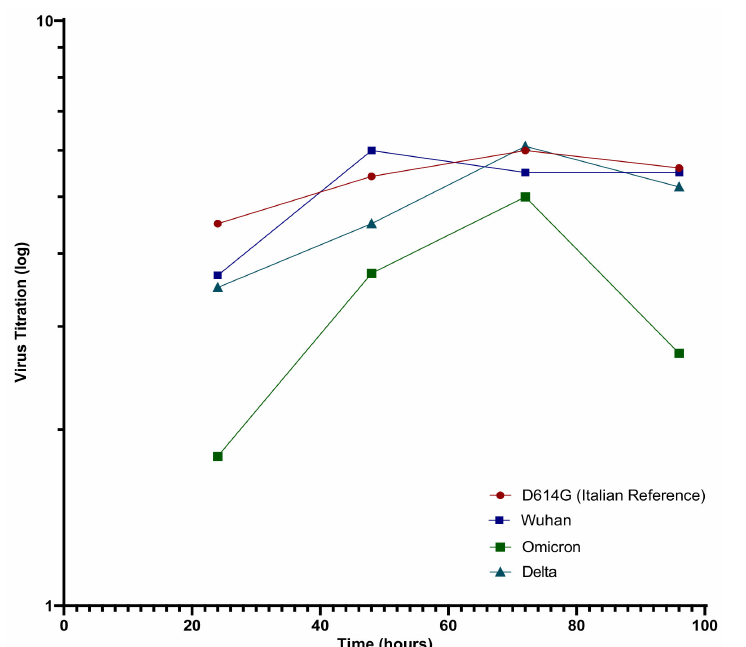
Figure 1. SARS-CoV-2 variants titration curves.